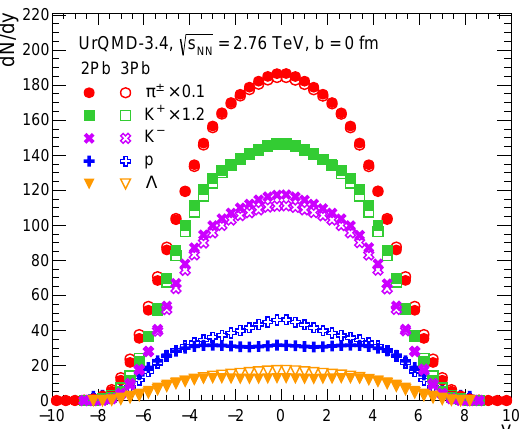
Figure 6. Comparison of the hadronic yields found for the central Pb+Pb BC (filled symbols) and for the central-simultaneous Pb+Pb+Pb TNC (open symbols) as the function of particle rapidity y